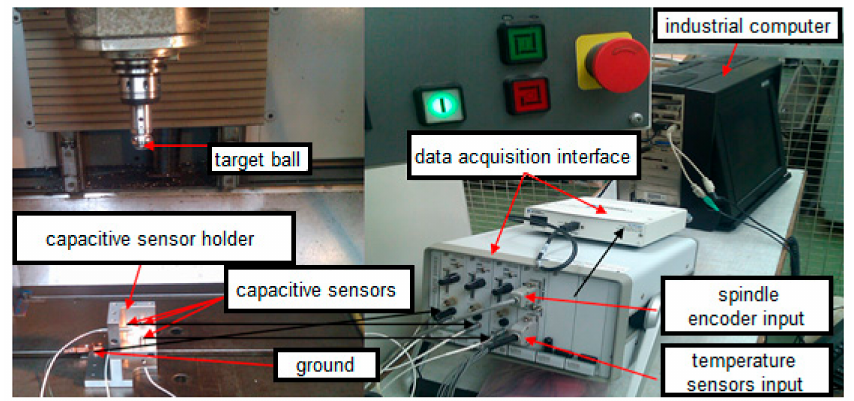
Figure 65. SEA measuring system on a test stand.